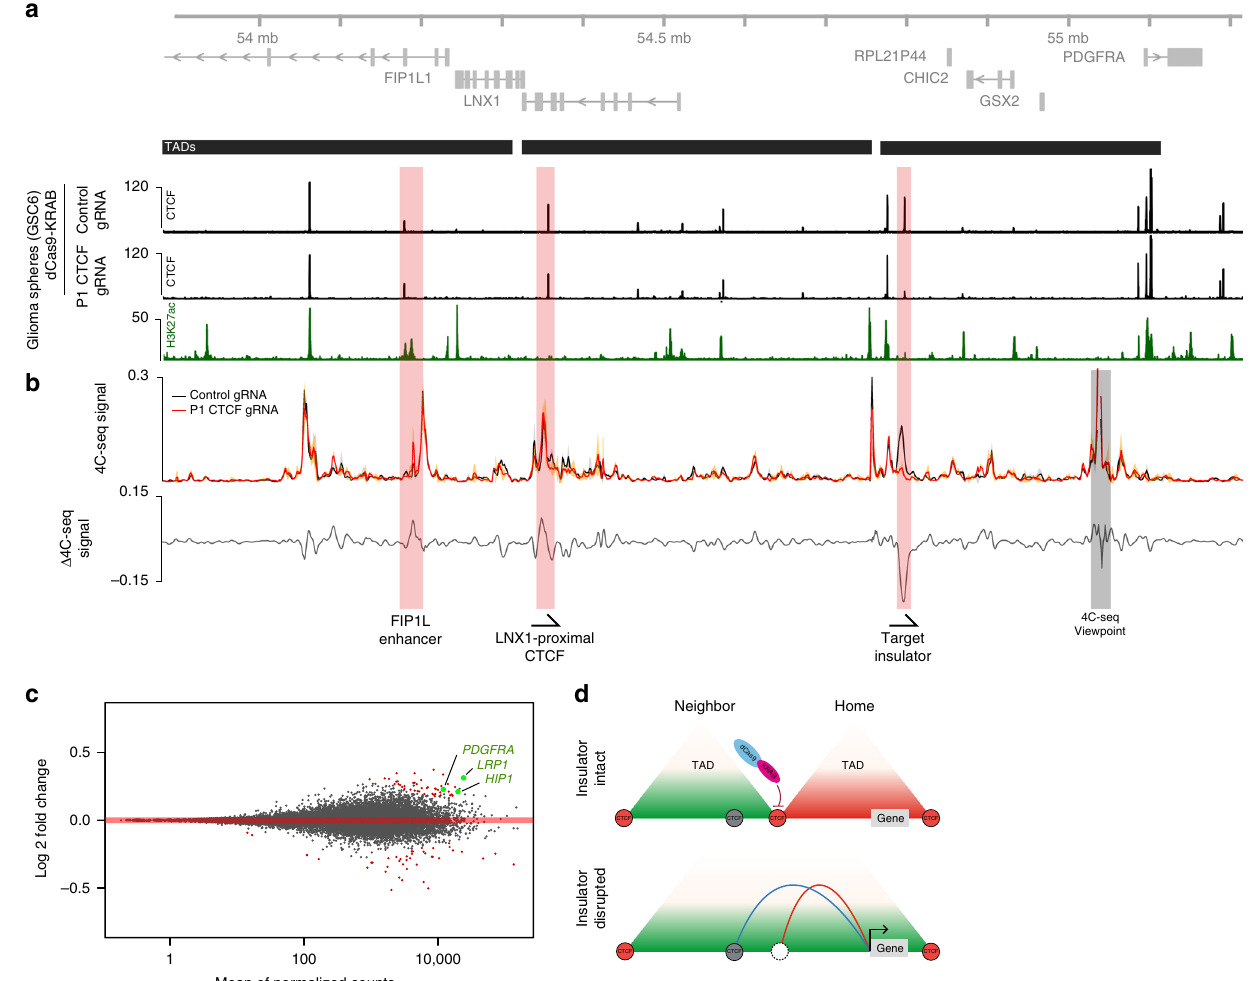
Fig. 3 Dissecting topological mechanisms of gene control with epigenome editors. a Genomic view of the expanded PDGFRA locus on chromosome 4 shows genes in gray (top). The region shown is divided into three TADs (black bars, middle), per HiC data. ChIP-seq signal tracks for CTCF (black) are shown for GSC6 cells following transfection with dCas9-KRAB plus single gRNA targeting the P1 CTCF site or non-targeting control. ChIP-seq for H3K27ac (a marker of regulatory activity) in GSC6 is shown green. b Plot shows 4C-seq signal measured from a viewpoint near the PDGFRA promoter. GSC6 cells were transfected with gRNA targeting the P1 CTCF site (red) or non-targeting control (black), as in a . Signal is shown as the mean across replicates (solid line) ± one standard deviation (shaded area around mean). The difference in 4C-seq signal between the two conditions is shown below the 4C-seq signal (gray line, bottom). Epigenome editing of the P1 site with dCas9-KRAB decreases interactions between the PDGFRA promoter and the CTCF insulator, and modestly increases interactions between the PDGFRA promoter and sites in the adjacent TAD, including the LNX1 proximal CTCF site, and the previously described FIP1L1-proximal enhancer. c Plot shows differential gene expression measured by RNA-seq from GSC6 cells following epigenome editing with dCas9-KRAB and single gRNA targeted to the P1 site or a non-targeting control. Differentially expressed genes ( P < 0.05) are highlighted (red). Differential PDGFR pathway genes are indicated (green). d Schematic depicts consequences of insulator disruption by epigenome editing. In glioma cells, insulator disruption at the PDGFRA locus increases interactions across the disrupted insulator, which may allow enhancers to contact sites in the neighboring TAD. Data are available via GEO accession